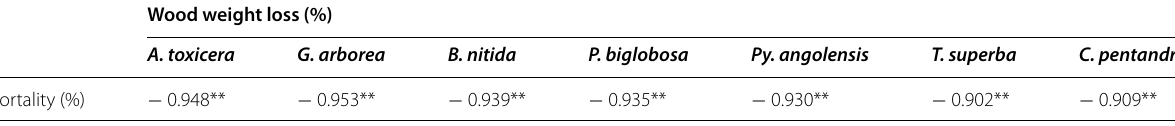
** Correlation is significant at 0.0001 level (2-tailed)